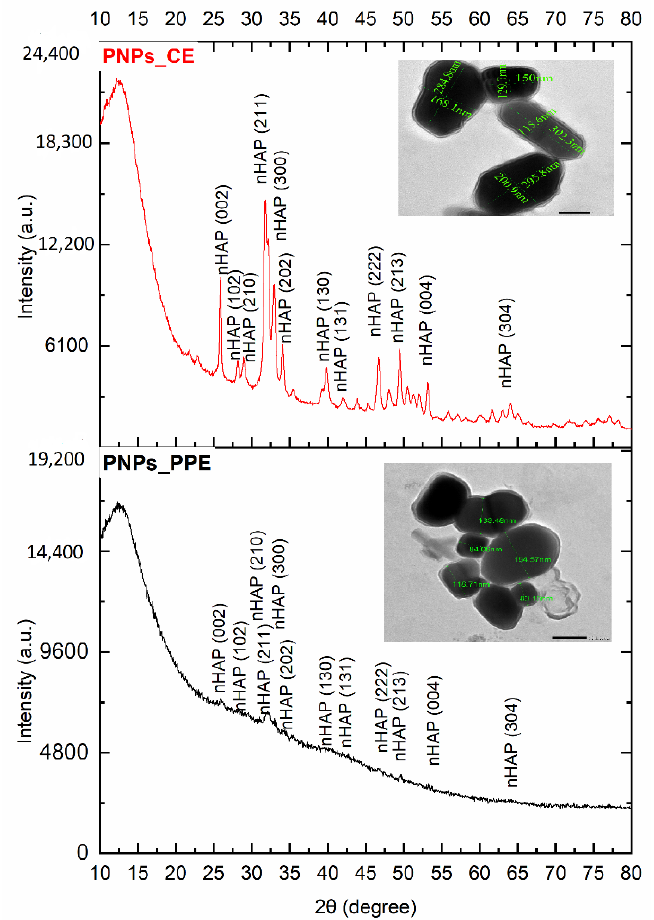
Figure 2. XRD patterns of nHAPs_PPE and nHAPs_CE. The top cornered TEM photomicrograph confirms the lattice shape of nanoparticles.